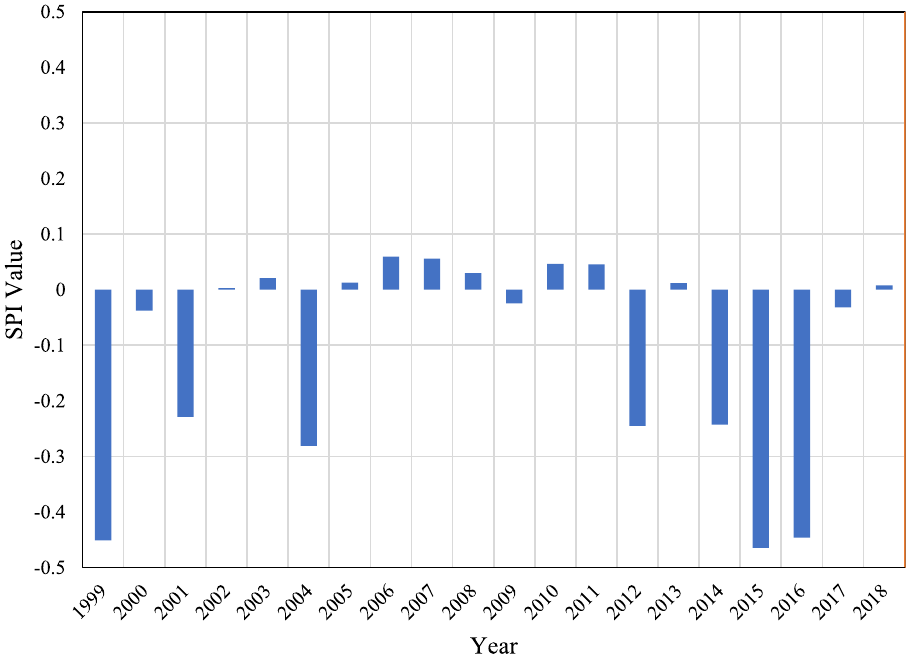
Fig. 16 SPI values of Nari and